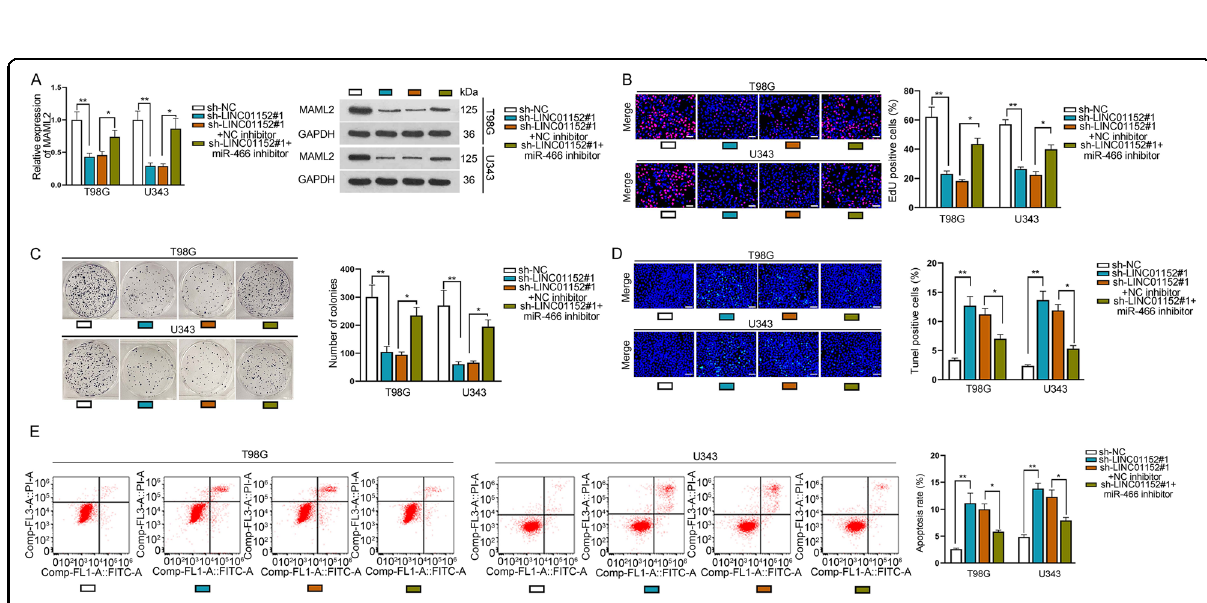
Fig. 4 LINC01152/miR-466/MAML2 axis could modulate the progression of GBM cells. A Expression of MAML2 was determined via qRT-PCR and western blot in T98G and U343 cells with LINC01152 depletion or together with miR-466 inhibition. B , C EdU (scale bar = 100 μ m) assay and colony formation assay assessed the proliferation of T98G and U343 cells under indicated conditions. D , E TUNEL (scale bar = 120 μ m) assay and fl ow cytometry analysis investigated the apoptosis of indicated T98G and U343 cells. * P < 0.05, ** P <